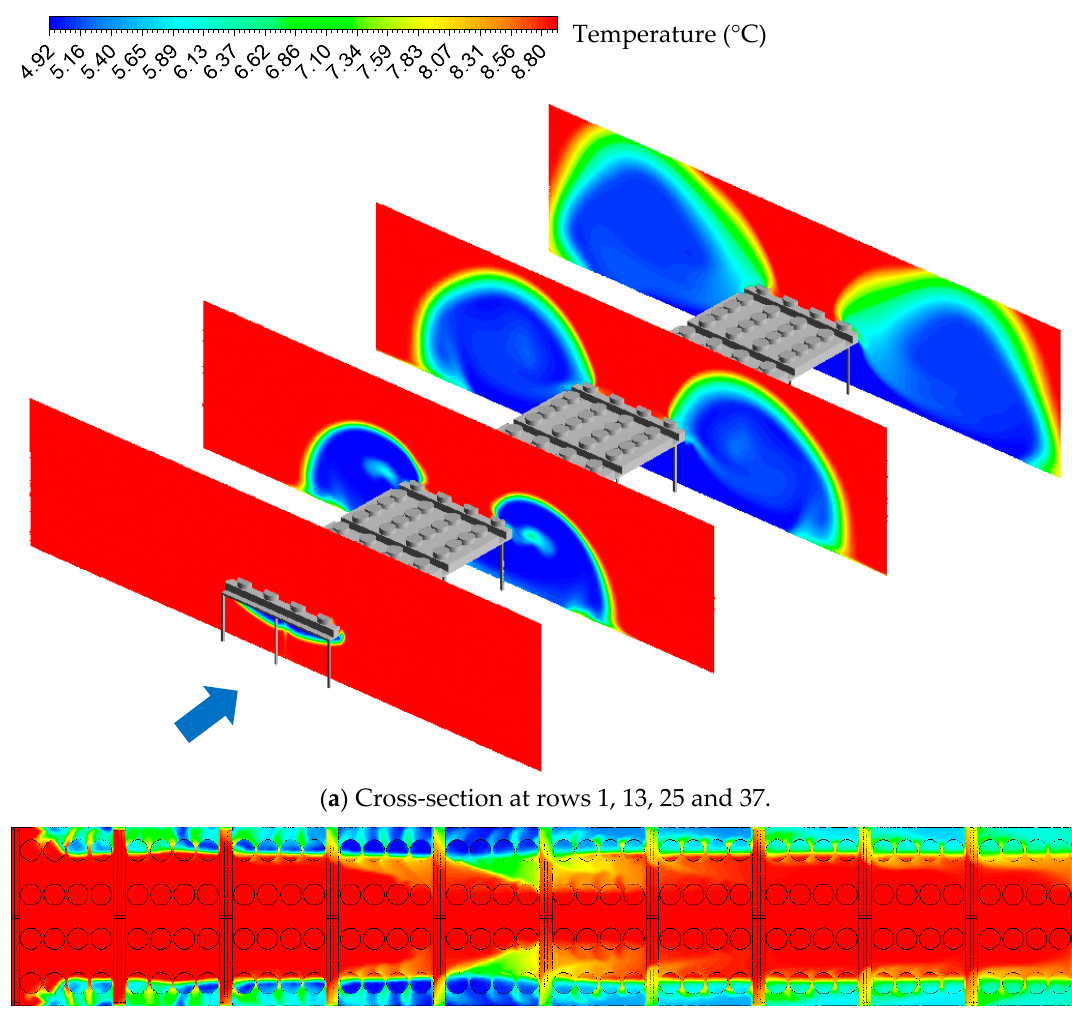
Figure 8. Temperature contour at different locations of the evaporators ( a ) and temperature contour on the top side of the evaporators ( b ) uniform field and south wind condition. Fluids 2020 , 5 , x FOR PEER REVIEW The intensity increases along the flow direction according to the development of the vortices.